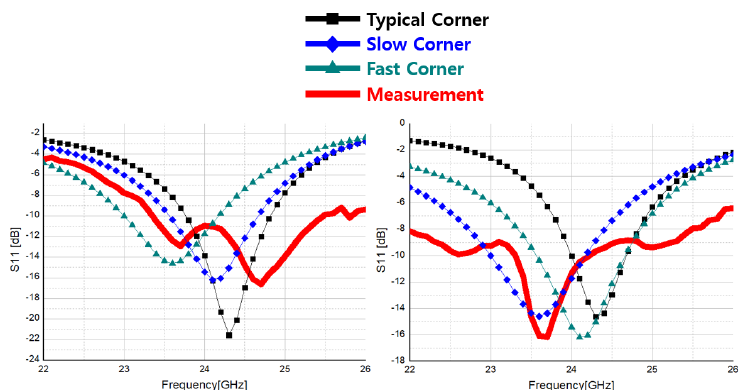
Figure 42. S 11 measurement and comparison with simulation: transmitter (left), receiver